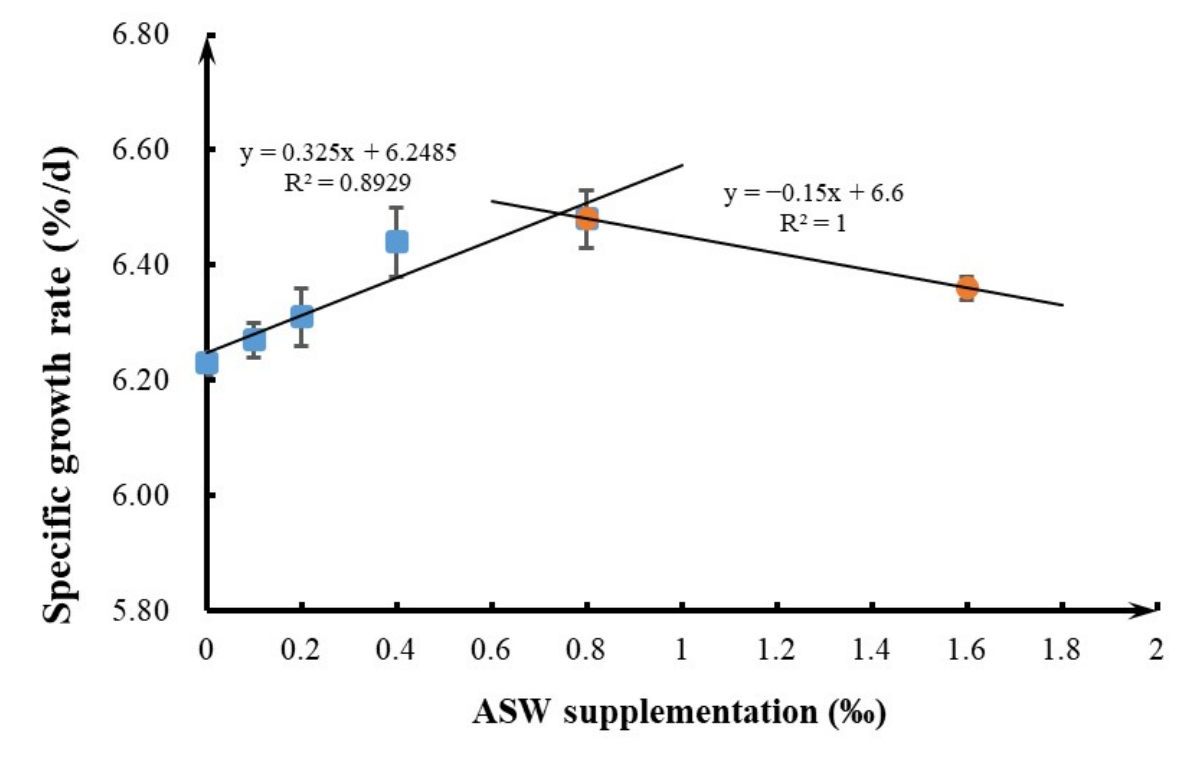
Figure 1. Relationship between specific growth rate and dietary supplementation with ASW * (mean ± SEM). Relationship was determined using a two-slope broken-line model [42].